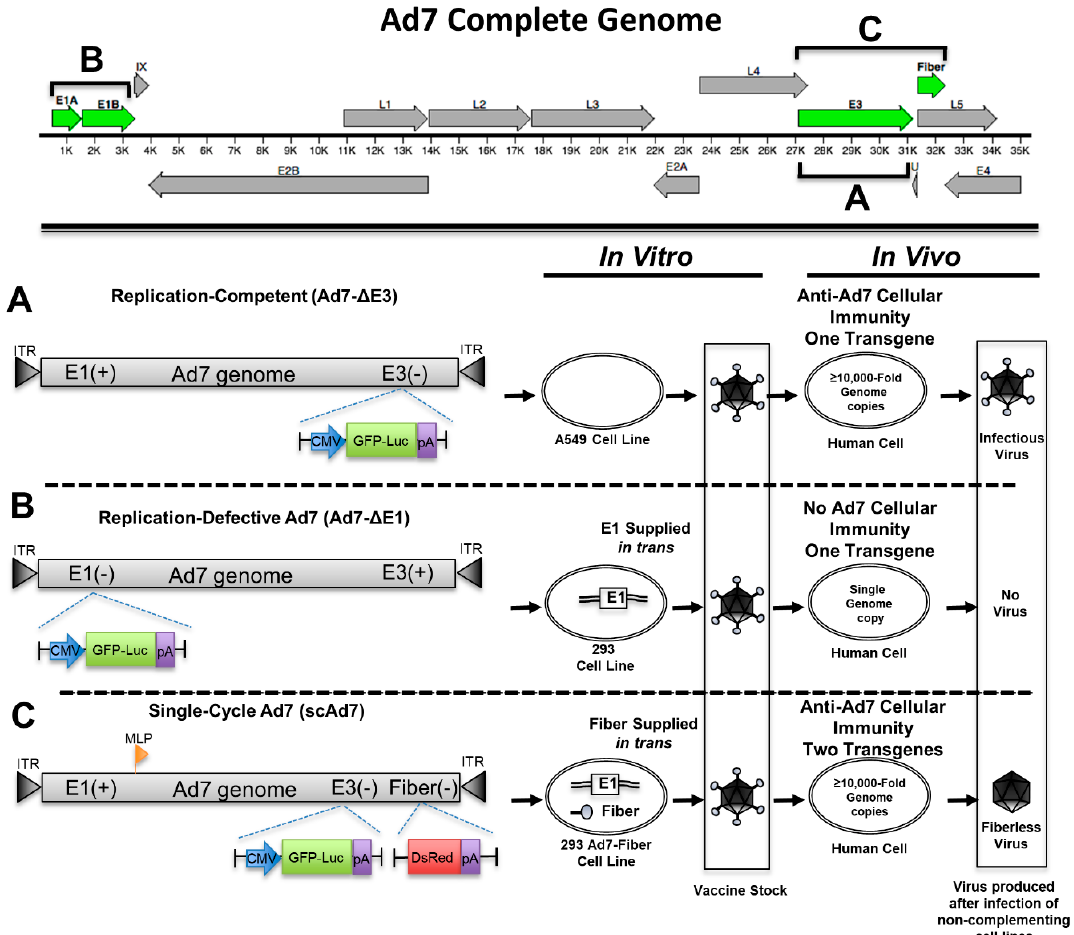
Figure 1. Genomic organization of three Adenovirus type 7 (Ad7) viruses. The complete Ad7 genome can be seen at the top with the manipulated Adenovirus genes highlighted in green. The replication-competent virus platform has the nonessential E3 genes replaced with a GFP-Luciferase (GFP-Luc) expression cassette ( A ). The replication-defective Ad7 virus has the essential E1 genes deleted and replaced with a GFP-Luciferase expression cassette. This virus requires the E1 gene in trans from the 293 cells in order to replicate ( B ). The single cycle Ad7 (scAd7) virus has the E3 genes and fiber deleted ( C ). The E3 genes are replaced with a GFP-Luciferase expression cassette, and the fiber gene has been replaced with a DsRed gene running off the major late promoter (MLP) during replication. The scAd7 virus can only produce an infectious virus in Ad7 fiber complementing cell line. However, transduction of normal cells results in ≥ 10,000-fold genome amplification and only produces fiberless virus with severely impaired infectivity. Table 1. Primers for the creation and testing of the scAd7 vaccine. These primers were used for the PCR amplification of the homologous flanking DNA used for inserting the DsRed gene in place of the